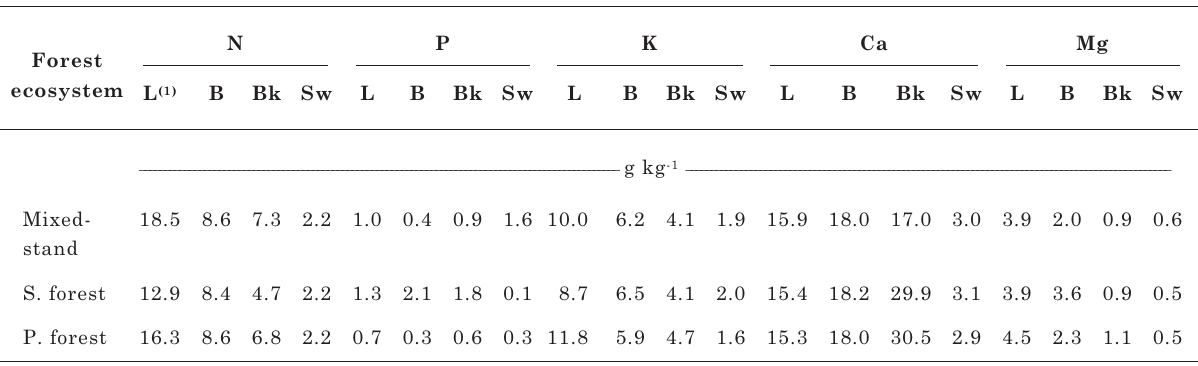
Table 6. Nutrient concentration in the above-ground components of the mixed-species stand, secondary forest and primary forest